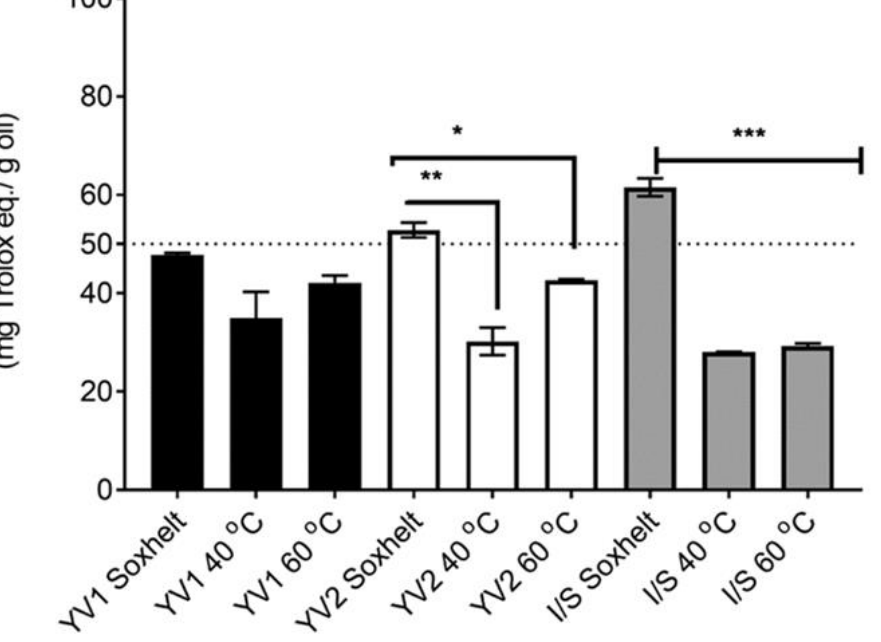
Figure 3. Antioxidant activity (mg Trolox eq./g oil) of OFI and OD oils extracted by SFE at 40 ◦ C, 60 ◦ C, and Soxhlet. Among each variety, different symbols (* p < 0.05, ** p < 0.01, *** p < 0.001) indicate significant differences compared to Soxhlet extraction.